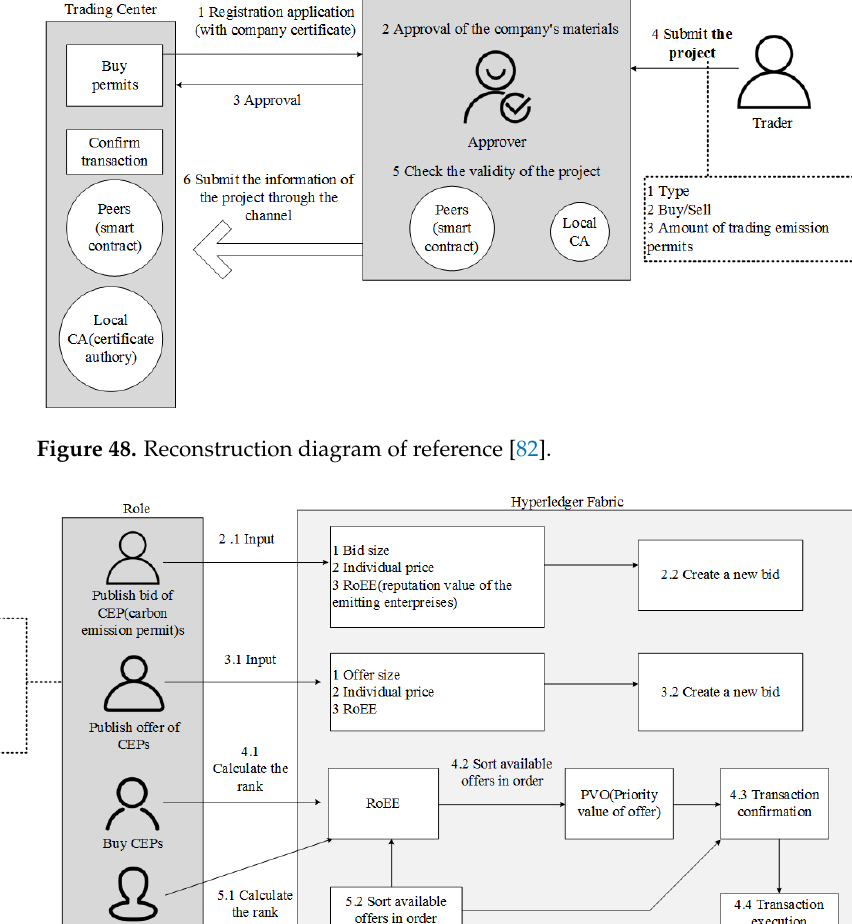
Figure 50. Reconstruction diagram of reference [84].